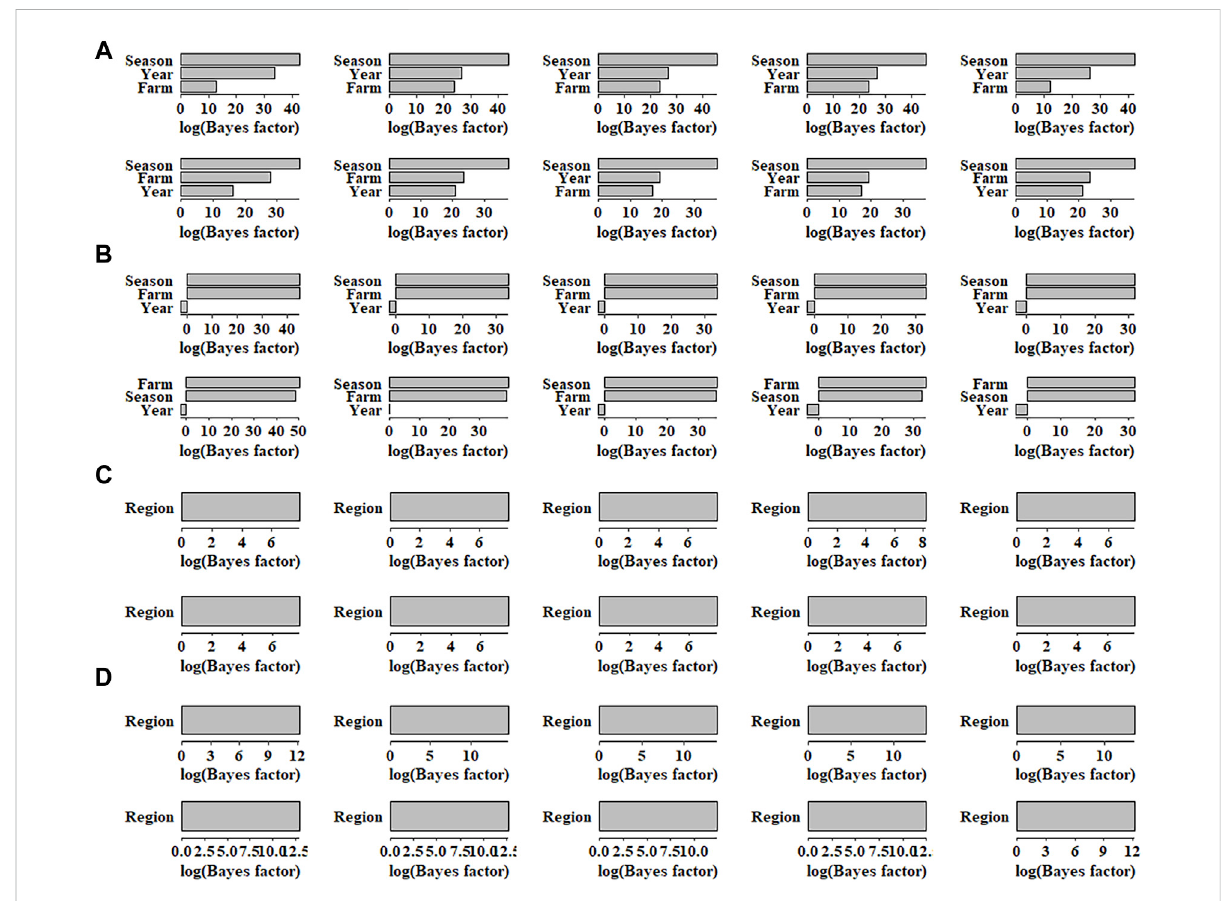
FIGURE 4 Bayes factors of 10 single nucleotide polymorphisms for (A) AGE, (B) BFT, (C) GW and (D) WC in different environmental factors. AGE: days to 100 kg; BFT: backfat thickness adjusted to 100 kg; GW: grain weight; WC: water content.